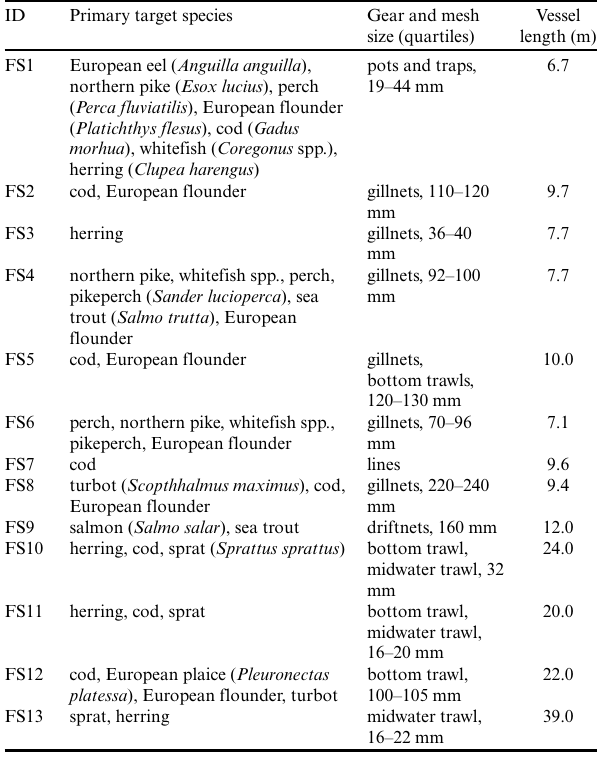
Table 1 . The 13 fishing strategies that are included in the study. Fishing strategies FS10–FS13 are large-scale fishing strategies. Modified from (Boonstra and Hentati-Sundberg 2014).